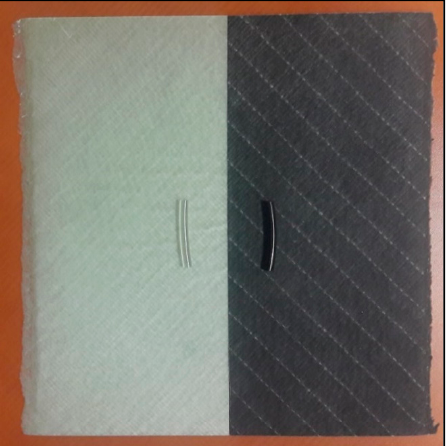
Figure 2. Plaques with net epoxy ( left ) and 1 wt% graphene addition to epoxy ( right ) and their respective epoxy.